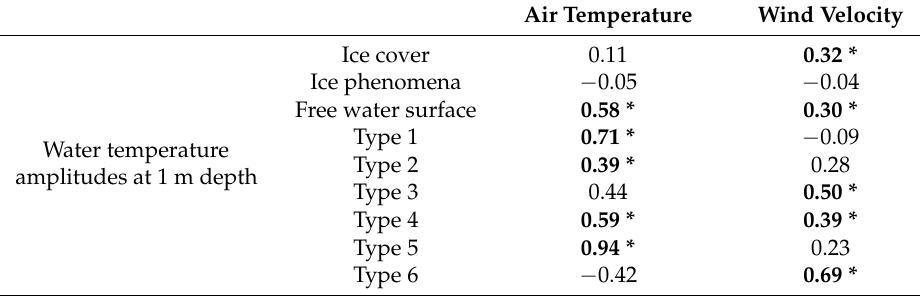
Table 4. Results of Spearman’s rank correlation analysis between air temperature, wind velocity, and temperature amplitude at level A (1 m depth) of Morskie Oko in the presence of ice cover, during the occurrence of ice phenomena, and in the period with no ice cover/ice phenomena for various types of profiles of temperature amplitudes. Air Temperature Wind Velocity Ice cover 0.11 0.32 * Ice phenomena − 0.05 − 0.04 Free water surface 0.58 * 0.30 * Type 1 0.71 * − 0.09 Water temperature Type 2 0.39 * 0.28 amplitudes at 1 m depth Type 3